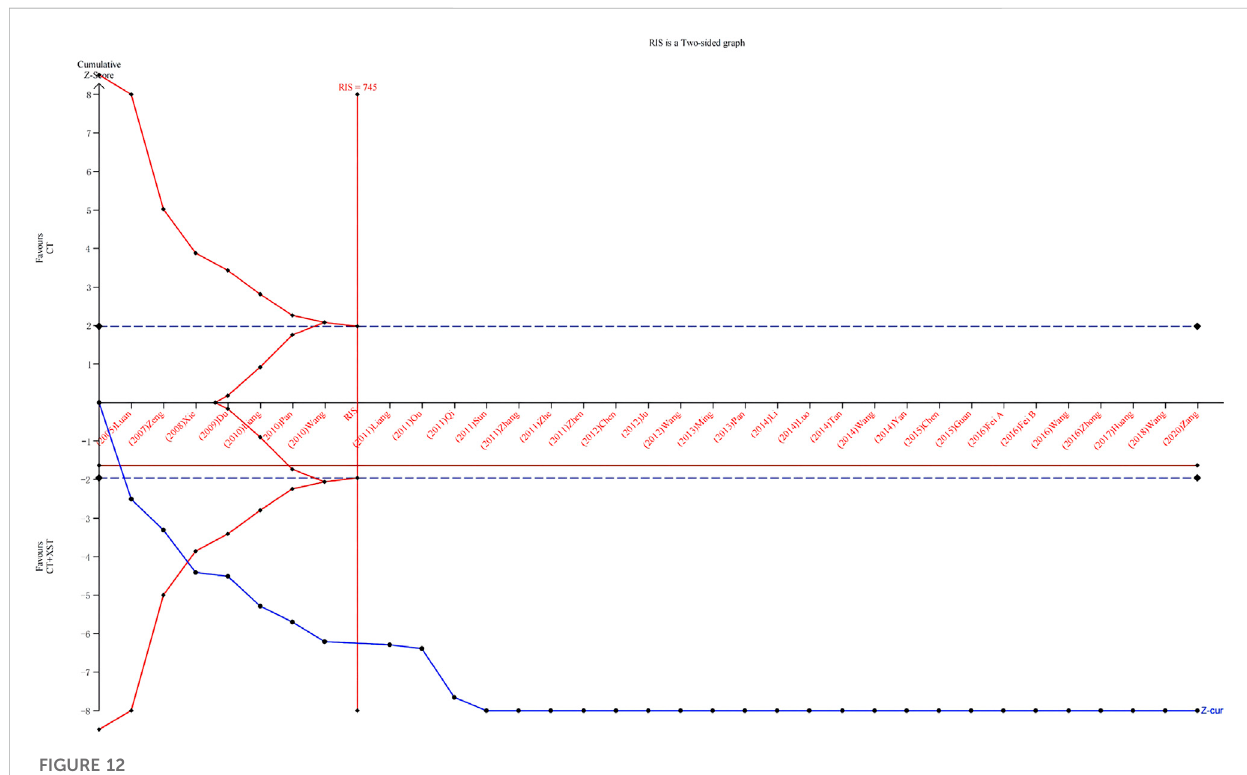
FIGURE 12 Trial sequential